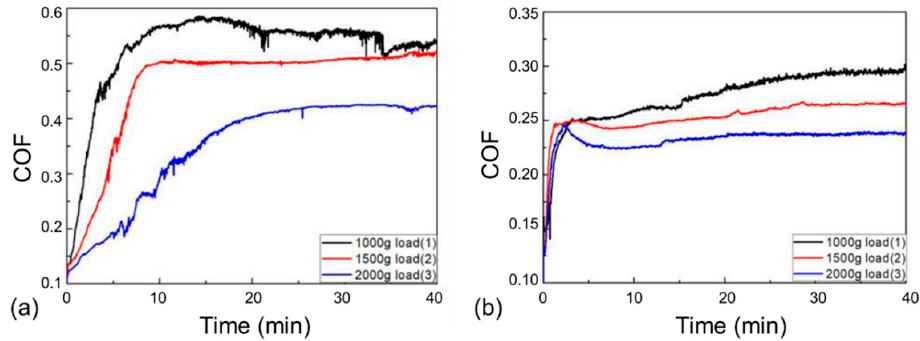
Figure 8. Friction coefficients of the ( a ) 27CrMoV substrate and ( b ) WC–10Co4Cr coatings at different loads.